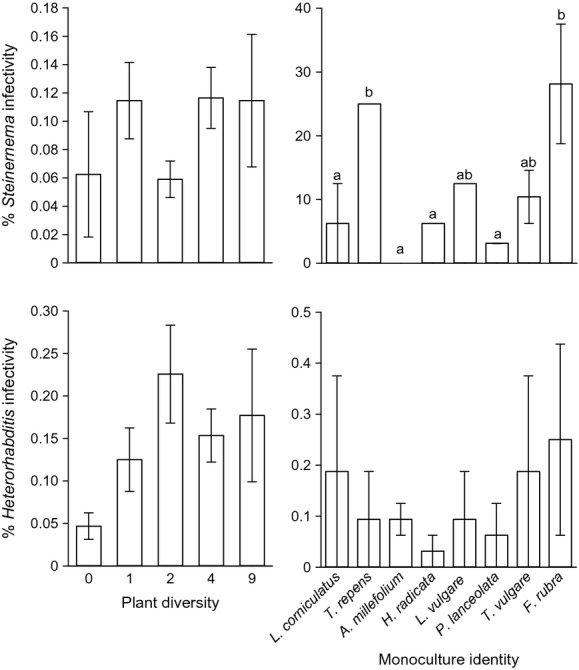
Effect of plant diversity and monoculture identity on mortality of G. mellonella larvae caused by Steinernema and Heterorhabditis spp. Means are calculated based on average values per plot ± between plot SE (if SE is not displayed, the mortality of G. mellonella larvae was equal in both plots). Different letters denote significant differences between monocultures (P < 0.05) based on linear mixed model with plot identity as random factor.